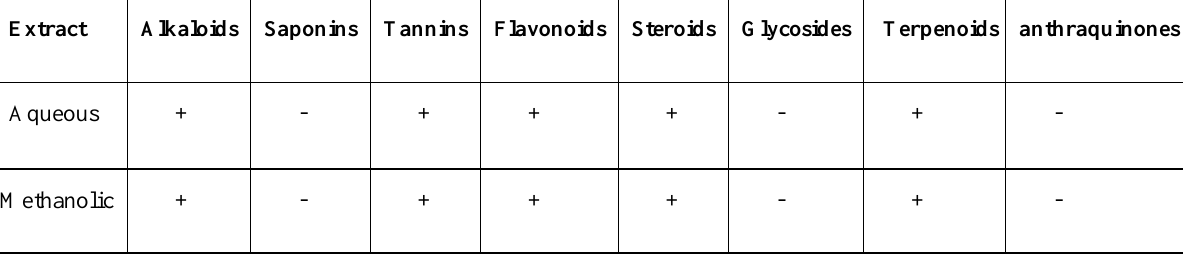
Table 3. Antimicrobial activity of the various C. sinensis leaves extract against the test organisms using agar well diffusion